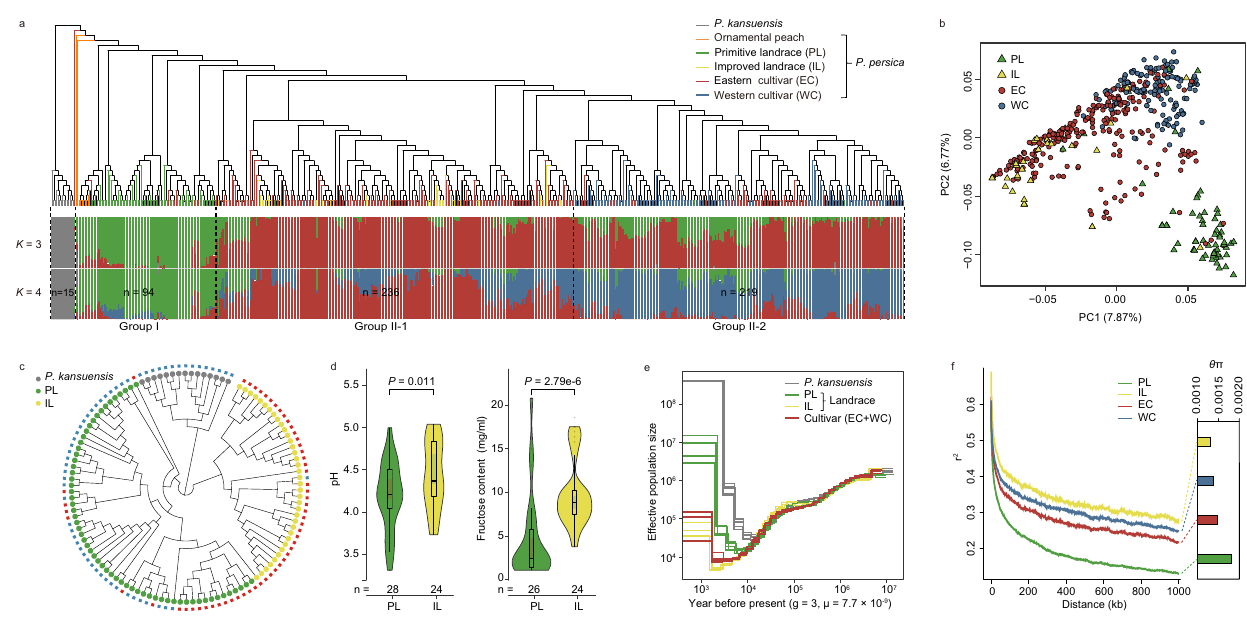
Fig. 2 Population structure and genetic divergence of primitive landraces and improved landraces. a Phylogenetic tree and model-based clustering of 564 peach accessions, including 549 cultivated P. persica accessions and 15 close wild relative P. kansuensis accessions. The neighbor-joining (NJ) tree and model-based clustering ( K = 3 and 4) were constructed based on a total of 337,386 SNPs. b PCA plot of the fi rst two principal components for all P. persica accessions ( n = 549) supported the classi fi cation of landraces (PLs and ILs), ECs, and WCs. Accessions with ambiguous/debatable geographic origins were excluded in subsequent analyses. c NJ tree for all PL and IL accessions supported the genetic divergence of PLs and ILs based on the same set of SNPs. The outer squares labeled with red and blue represent the accessions from eastern China and from central and western China, respectively. d Signi fi cant divergence of the pH and fructose content of the PL and IL accessions. The number ( n ) of individuals for each peach type is shown below. In the violin plots (signi fi cance was tested with Wilcoxon tests), central line: median values; bounds of box: 25th and 75th percentiles; whiskers: 1.5 * IQR (IQR: the interquartile range between the 25th and 75th percentile). e Demographic analysis for different groupings of peach accessions. A multiple sequentially Markovian coalescent (MSMC) model was used to infer their effective population fl uctuations under a mutation rate μ = 7.7 × 10 – 9 per site per generation 112 and the generation time of 3 years (and generation time of 4 years in Supplementary Fig. 7). f Linkage disequilibrium (LD) patterns and genetic diversity ( θπ ) for the four different types of P. persica . Source data underlying Fig. 2f are provided as a Source Data fi